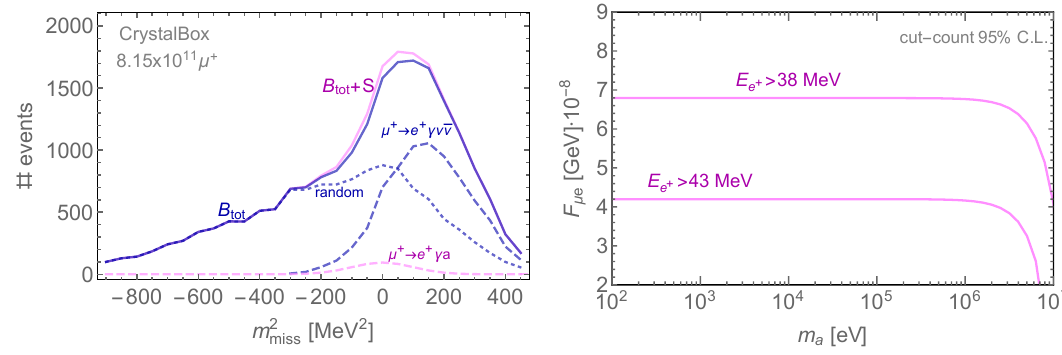
Figure 7 . Left: Missing mass distribution of background and signal events in Crystal Box after the cuts in eqs. (4.6), (4.7) are implemented and experimental efficiencies taken into account. Solid blue is the total background composed by the dashed blue distribution of µ + → e + γν ¯ ν events and the dotted blue distribution of events where a hard photon from µ + → e + γν ¯ ν and a positron from µ + → e + ν ¯ ν are randomly coincident. Solid magenta shows the combined background plus signal distribution. The dashed magenta is the signal shape smeared by the experimental resolution for m a = 0 and BR ( µ + → e + γa ) = 3 × 10 − 9 . Right: the 95% C.L. sensitivity of Crystal Box that we obtain using the simple cut and count scheme as described in the main text. The two lines indicate how the final bound on F depends on the positron energy loss before it reaches the detector. The µe actual experimental bound reaches a 30% higher value of F and is reported in eq. µe